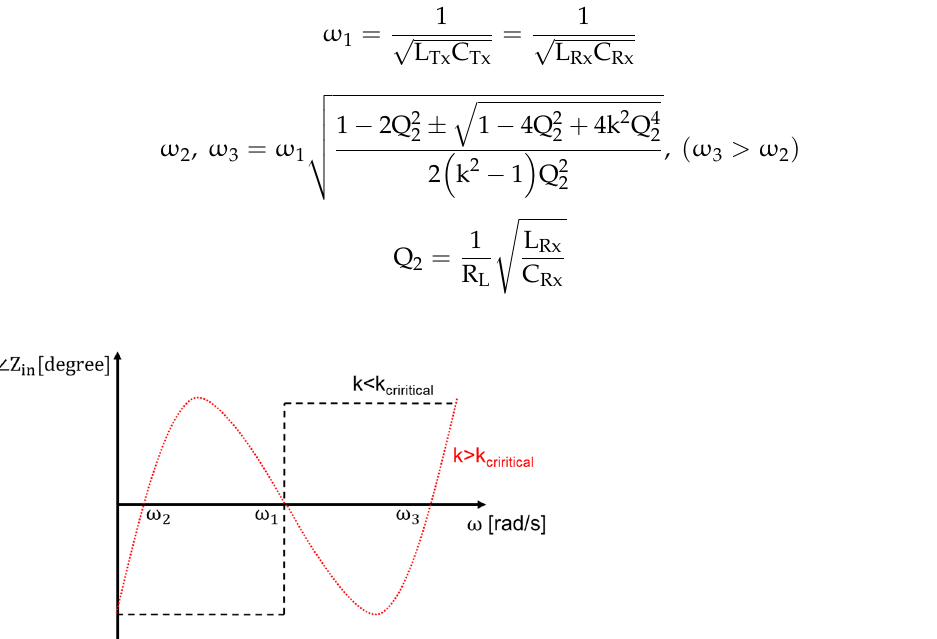
Figure 2. Schematic diagram of the phase of the input impedance according to the coupling coefficient and frequency.